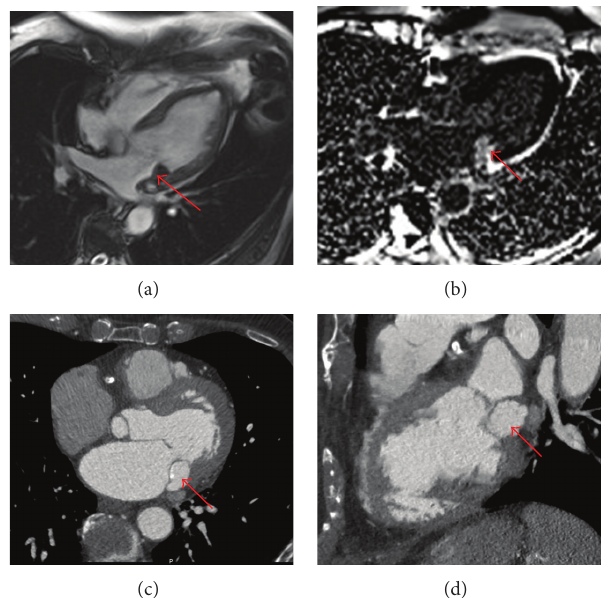
Figure 2: Axial CMR images demonstrating the location of the mass on the posterior annulus that usually is of low intensity signal on T2 and bright signal on T1 (a) and delayed enhancement image at the same location demonstrating external fibrosis with central liquid or proteinaceous core (b). Axial and coronal images of the caseoma with cardiac window on CCTA ( kVp = 120 with care dose variable mAs and slice thickness of 0.7mm with 0.4 overlap) with hyper-attenuated homogenous core and calcified edge with Hounsfield unit (HU) > 700 ((c),